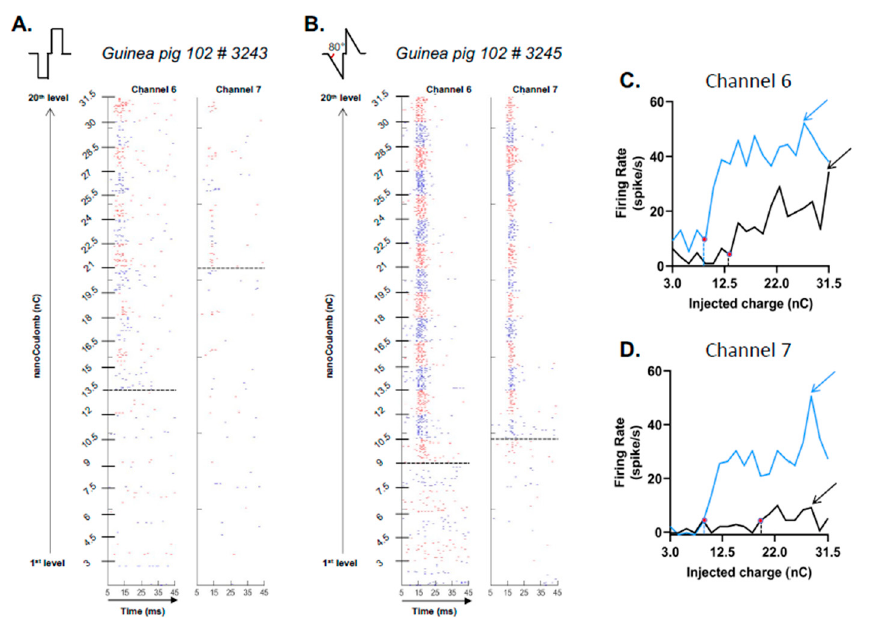
Figure 2. Individual examples of evoked firing rate and threshold of auditory cortex neurons with the rectangular cathodic pulses ( A ) and with one of the ramped pulse shape cathodic pulses ( B ). In ( A , B ), the rasters represent the raw evoked responses obtained in the auditory cortex for two simultaneous recordings (labeled channels 6 and 7) with increasing levels of charges from 3 to 31.5 nC (see the scale on the left side of each panel). In these rasters, each dot represents the occurrence of an action potential and each change from blue to red in the raster indicates an increase in charge level. The dashed lines indicate the threshold value obtained for each recording, i.e., the charge level triggering an evoked firing rate one standard deviation above spontaneous activity (see Methods for details). (A) Evoked responses obtained with rectangular cathodic pulses. ( B ) Evoked responses obtained with ramped cathodic pulses. Note the large increase in the number of action potentials triggered at each stimulation pulse when ramped pulses were used compared to rectangular pulses. ( C , D ) Quantification of evoked responses for the two channels displayed in ( A , B ). In both cases, the growth functions display the evoked firing rate (minus the spontaneous activity) as a function of the charge level obtained with rectangular pulses (black curve) and with the ramped pulses (blue curve). Both in ( C , D ) the red dots indicate the charge level considered as threshold and the arrows charge level where the maximal evoked firing rates was detected.